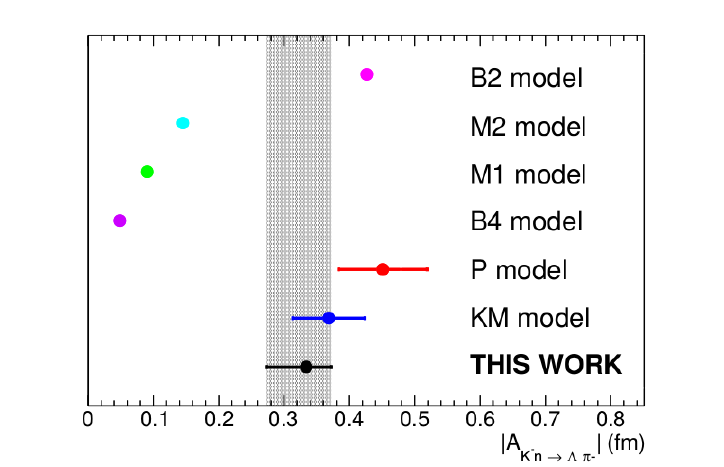
Figure 2. (Color online) Modulus of the measured non resonant K − n → Λ π − transition amplitude compared with theoretical calculations, see details in the